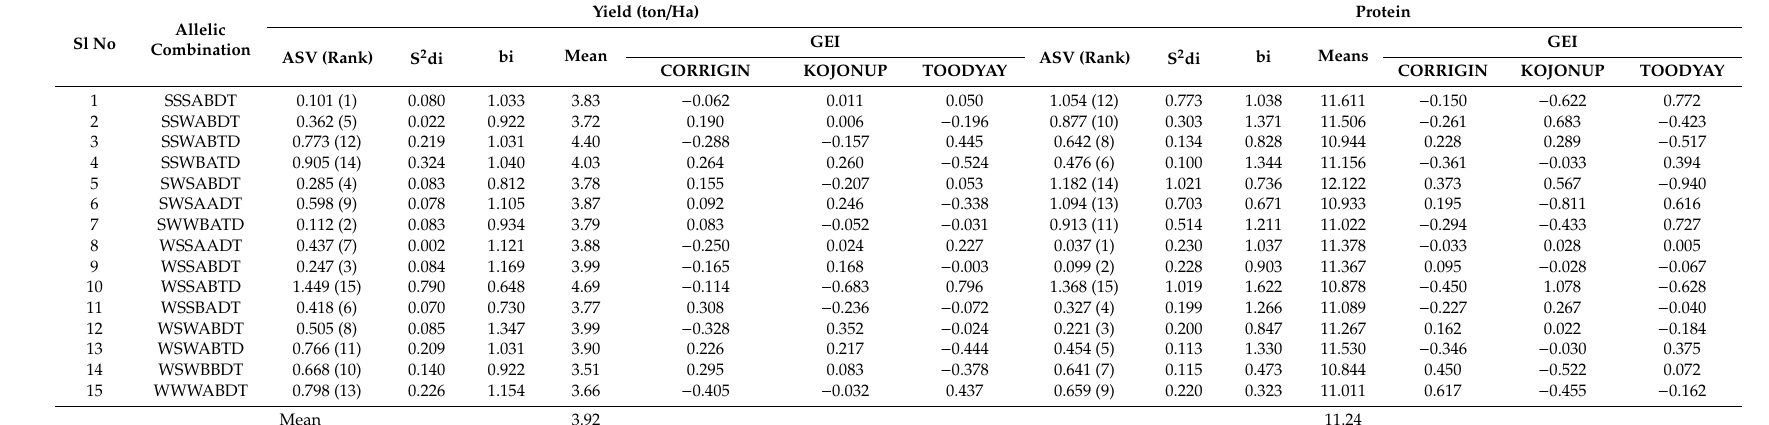
Table 4. Stability parameters and environmental e ff ects on the allelic combinations for yield and protein